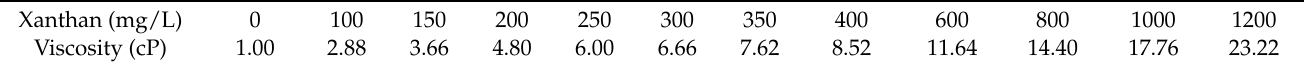
Table 1. Viscosity for xanthan at different